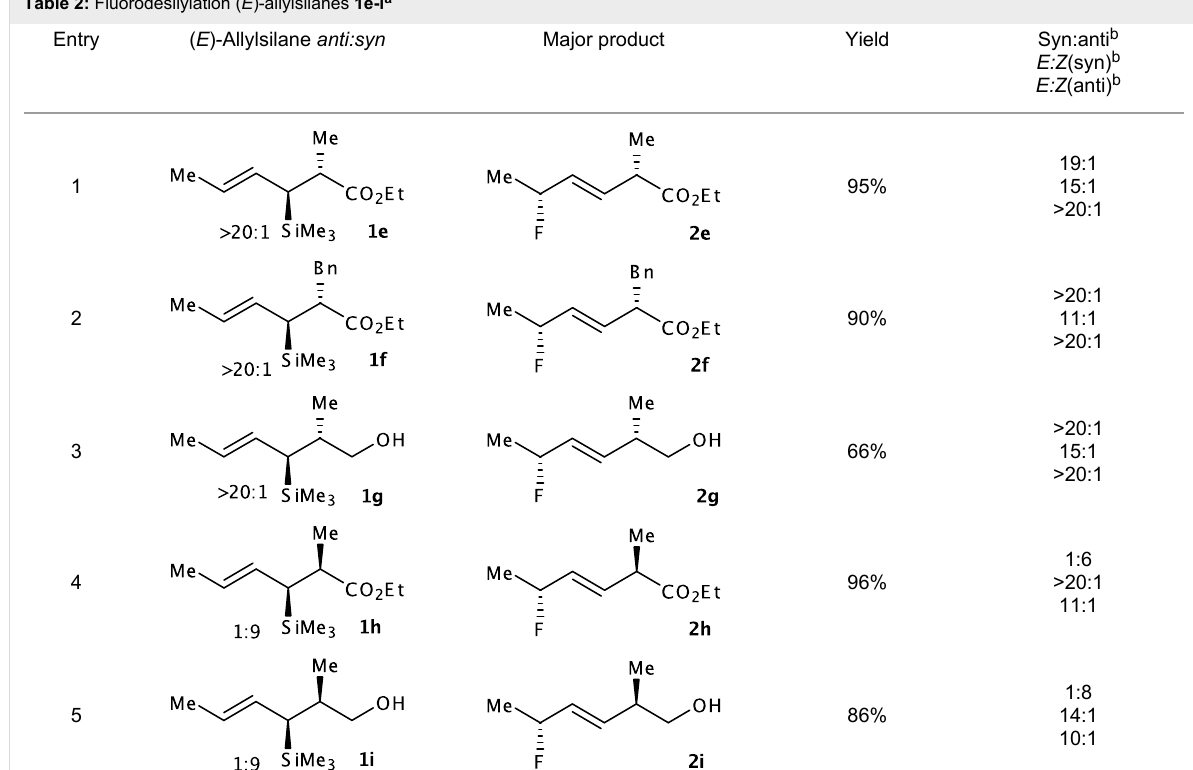
Table 2: Fluorodesilylation ( E )-allylsilanes 1e-i a Entry